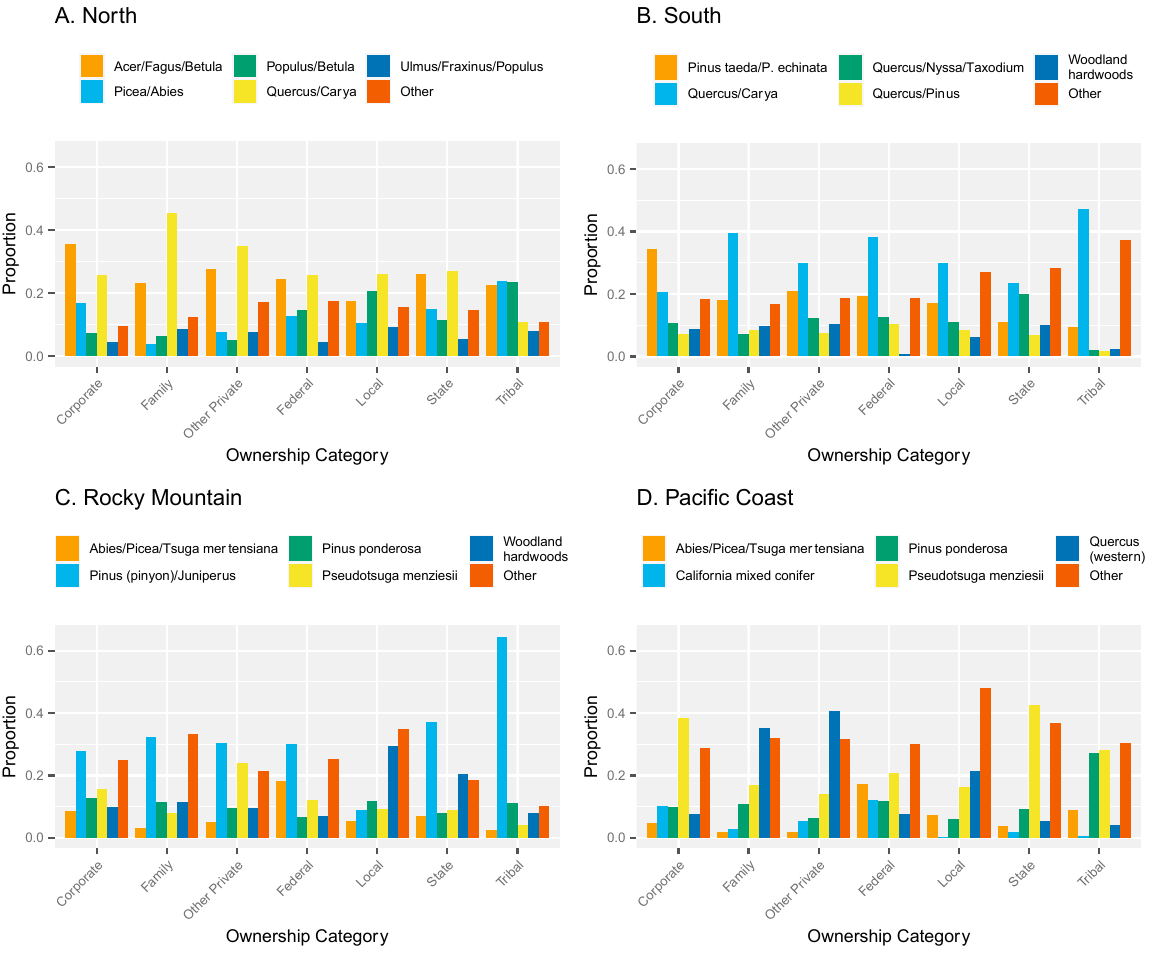
Figure 3. Relative proportion of forestland by forest-type group, and ownership category for the ( A ) North, ( B ) South, ( C ) Rocky Mountain, and ( D ) Pacific Coast regions, conterminous USA, 2019. The top five forest-type groups, based on area, in each region are presented. Data source: [20]. Stands dominated by large trees occupy a plurality of the forestland across all own- ership categories, ranging from 49% for Corporate forestland to 73% for Tribal forestland (C&I 1.1.a; Figure 4. Most other stands are dominated by either medium or small sized trees with a relatively even distribution between the two for most ownership categories. Non-stocked stands range from 2% of the forest area for Family and Other private forestlands to 5% for Federal forestland.